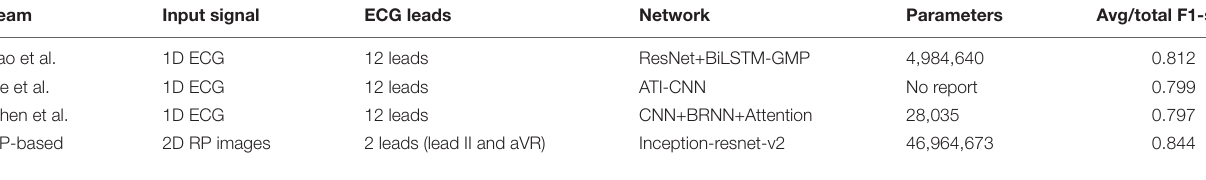
TABLE 7 | Data profile for the CPSC, PTB_XL, and Georgia ECG dataset.